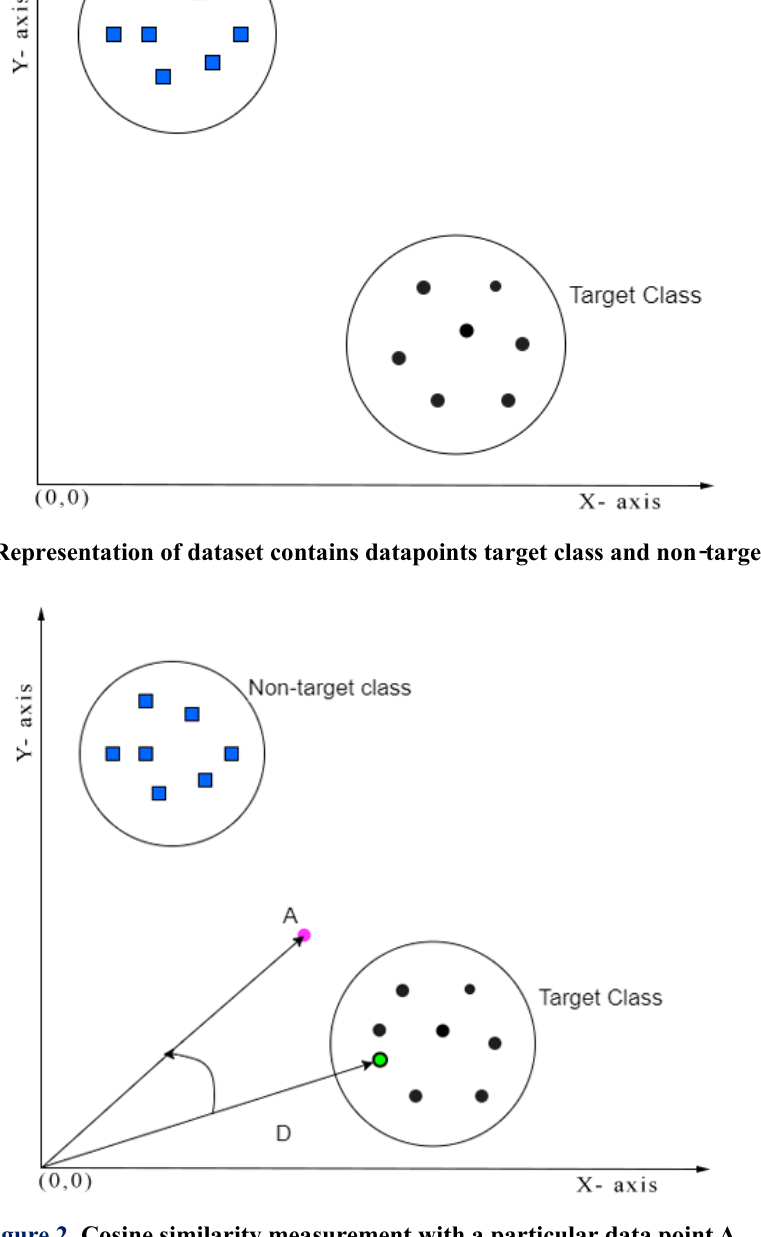
Figure 2. Cosine similarity measurement with a particular data point